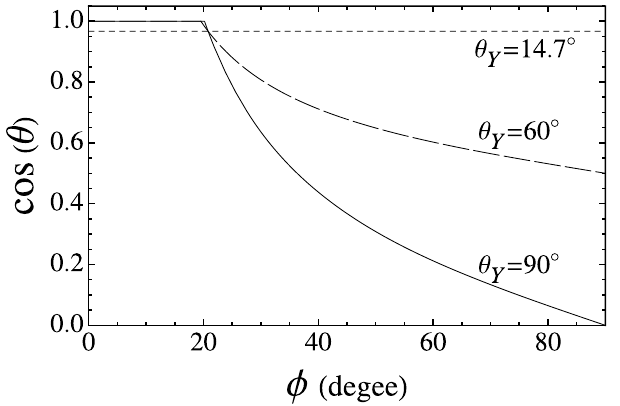
Figure 6. Cosine of the microscopic contact angle θ as a function of polar angle φ for several values of θ Equations 24 and 25 with = . r nm 3 35 . Constraint by the measured microscopic contact and polar angles, gives p the crossing point {20.8, 0.967} for the angles from Table 3. Geodesic curvature vanishes at the seed equator (polar angle) where θ θ = = . cos cos 0